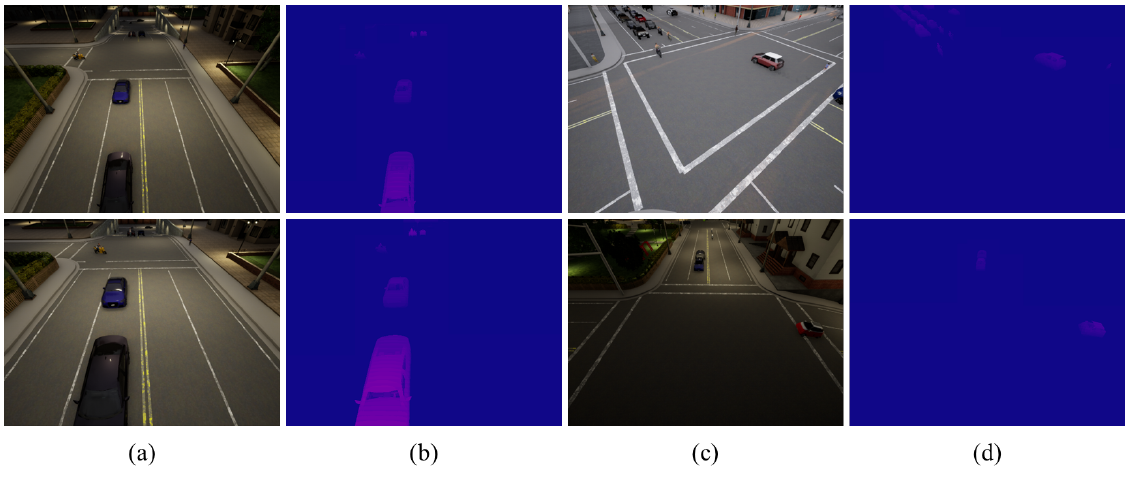
Figure 2. Images generated from CARLA simulator [23] with different weather conditions ( 1st row ), different times of the day ( 2nd row ), different camera locations ( 3th row ), and different camera heights ( 4th row ).